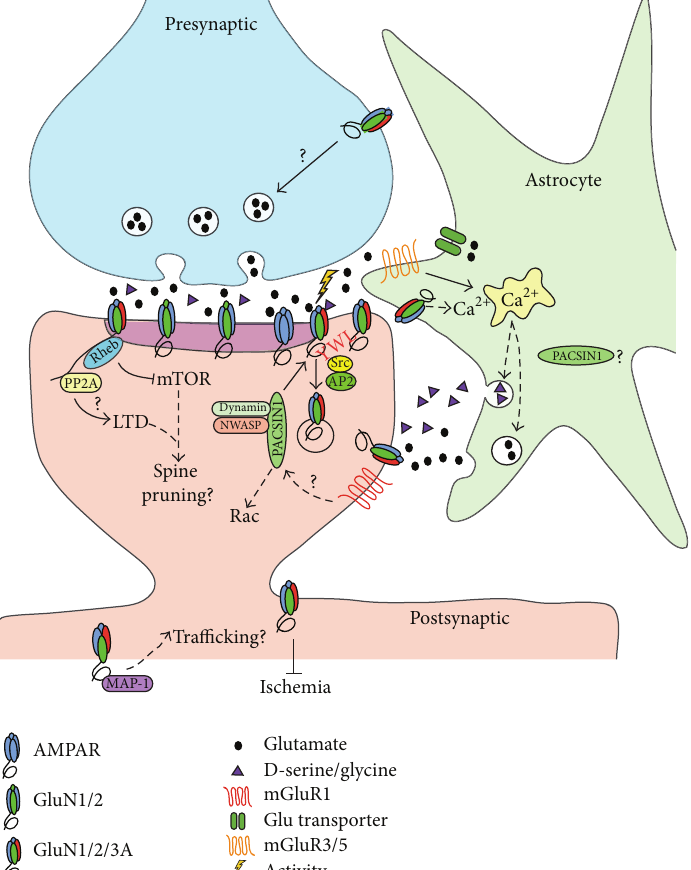
Figure 2: Schematic of the proposed distribution of GluN3A-containing NMDAR in the pre- and postsynaptic sites as well as on astrocytic processes. Endocytosis of GluN3A is activity dependent, driving PACSIN1 binding and Src phosphorylation of the YWL motif to selectively internalize GluN3A-containing NMDAR. Other molecular interactions with GluN3A could play roles in trafficking of the receptor subunit and dendritic spine dynamics. The roles of GluN3A in astrocytic processes still remain unclear but it could potentially exert an attenuating effect on calcium entry in a reciprocal manner to mGluR calcium